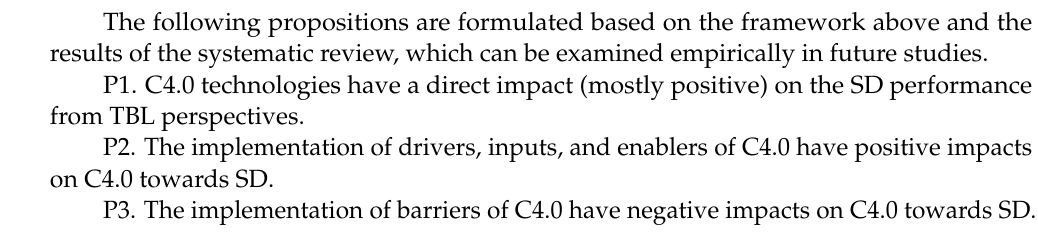
Figure 11. A framework of Sustainable C4.0